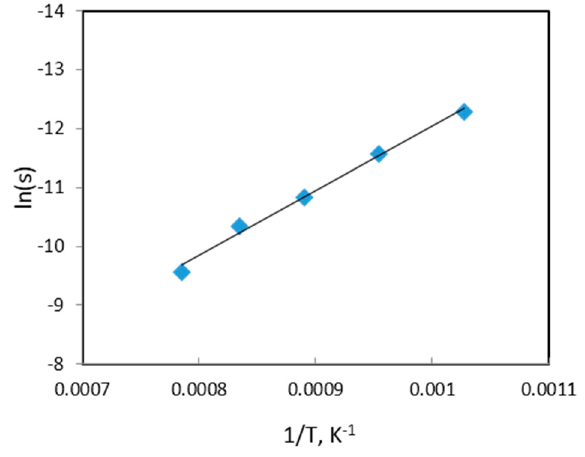
Figure 19. Arrhenius plot for the reduction of NiWO 4 by hydrogen using laser flash unit.